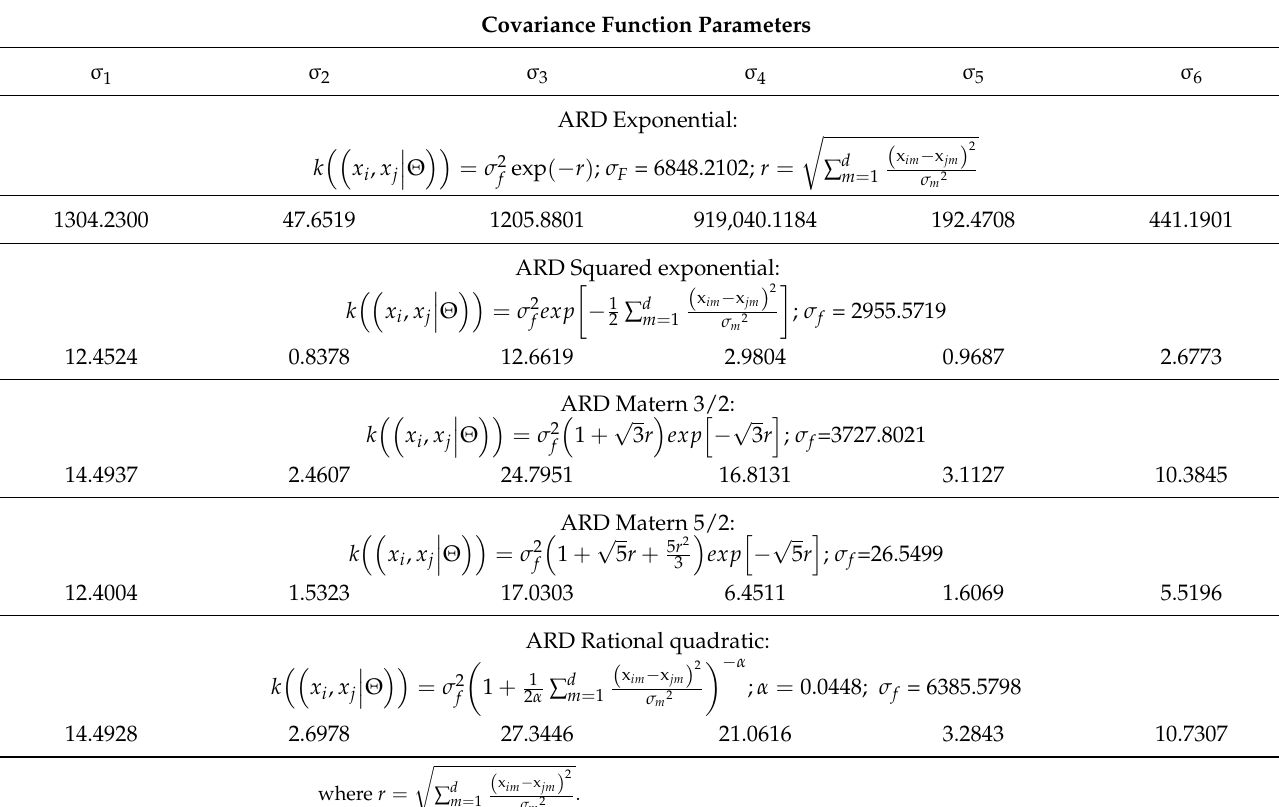
Table 3. Parameters of GPR ARD model covariance functions.